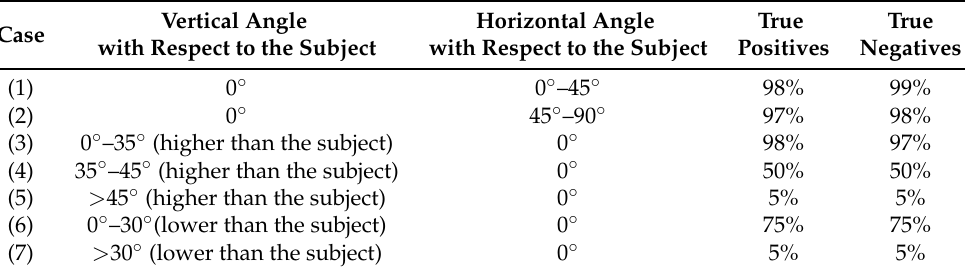
Table 5. Set of angles under the fall detection algorithm